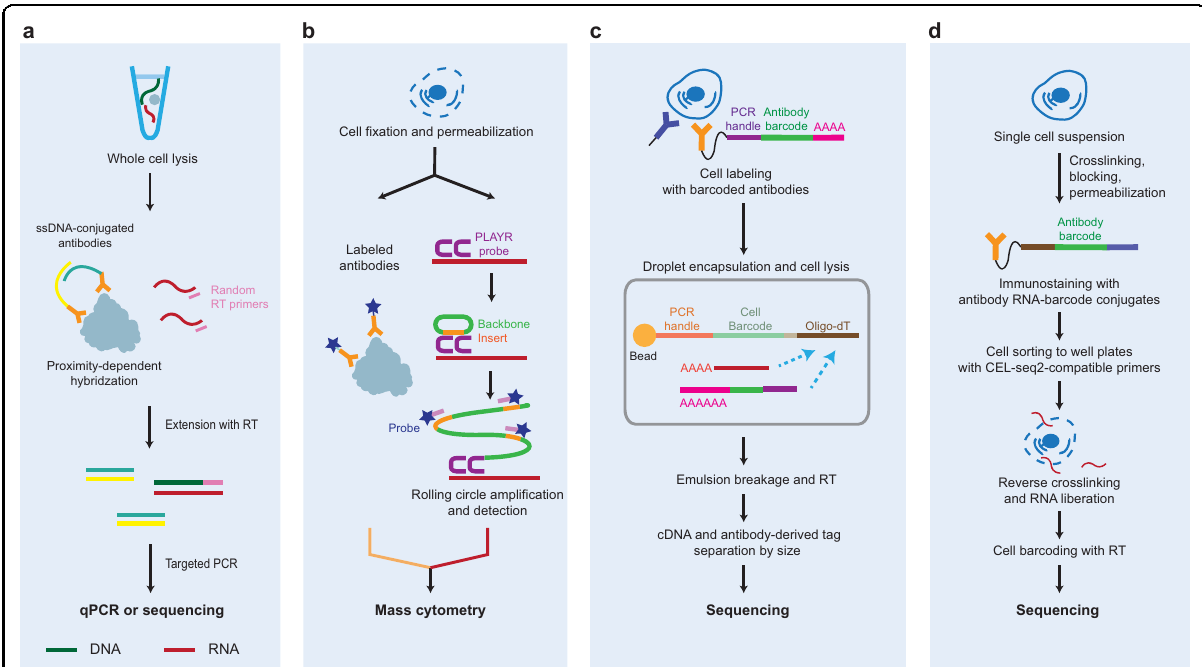
Fig. 4 Single-cell multiomics sequencing protocols for integrative analyses of the transcriptome and proteome. Protocols for the isolation of single cells and the barcoding of mRNAs and proteins are shown for four types of multiomics analyses of the transcriptome and proteome: PEA/STA ( a ), PLAYR ( b ), CITE-seq ( c ), and RAID ( d ). Green-blue line, single-stranded DNA (ssDNA) oligos conjugated to antibodies; rotated U shapes, PLAYR probes; green-orange circle, backbone-insert oligos; and DNA fragments containing stars, isotope-labeled probes. See the legend of Fig. 2 for the other symbols and the text for the de fi nitions of the